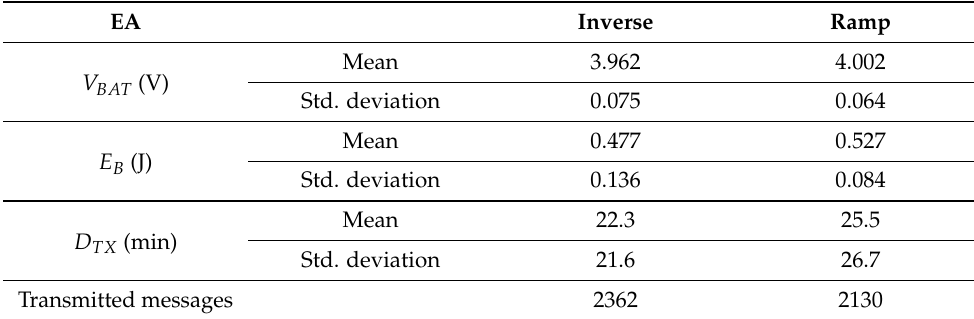
Table 3. EA algorithm comparison over 40 days.